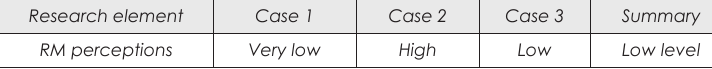
Table 15: Summary of findings Research